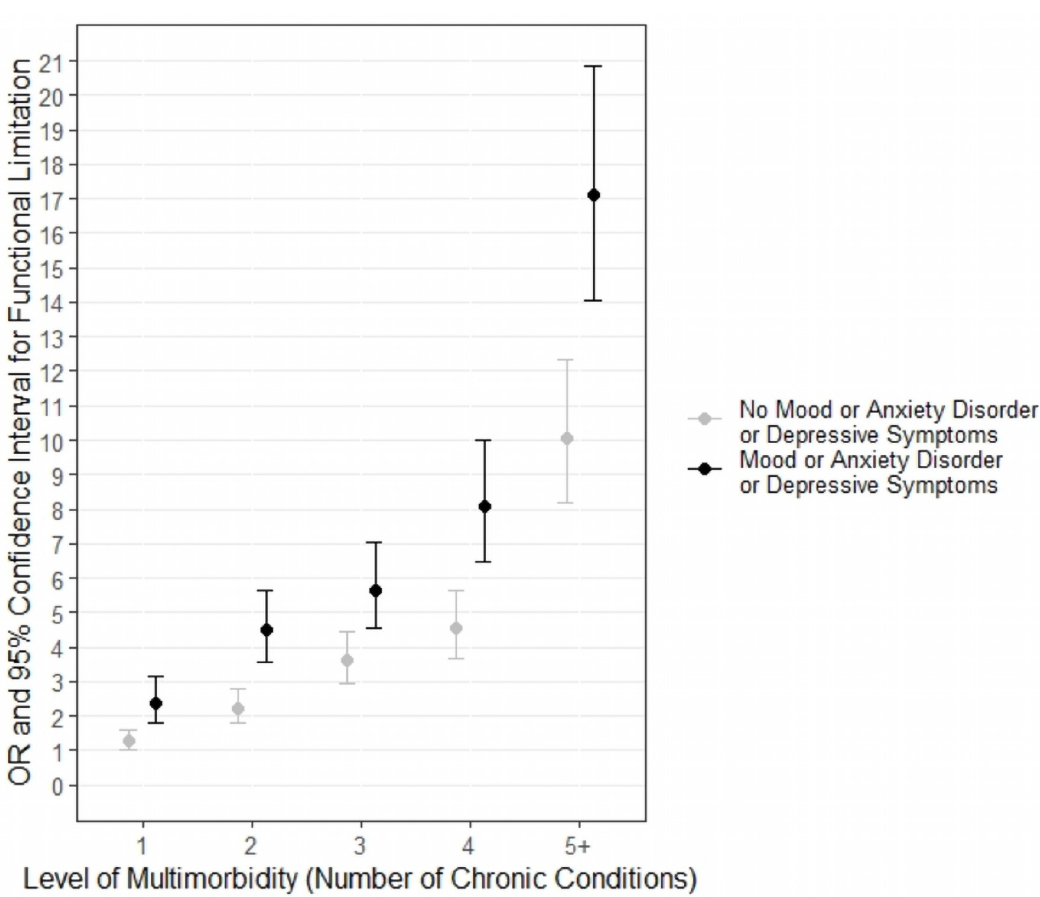
Fig 4. Odds of functional limitation by multimorbidity and presence of mood/anxiety/CESD disorders (reference category—0 chronic conditions, models adjusted for age, sex, education).